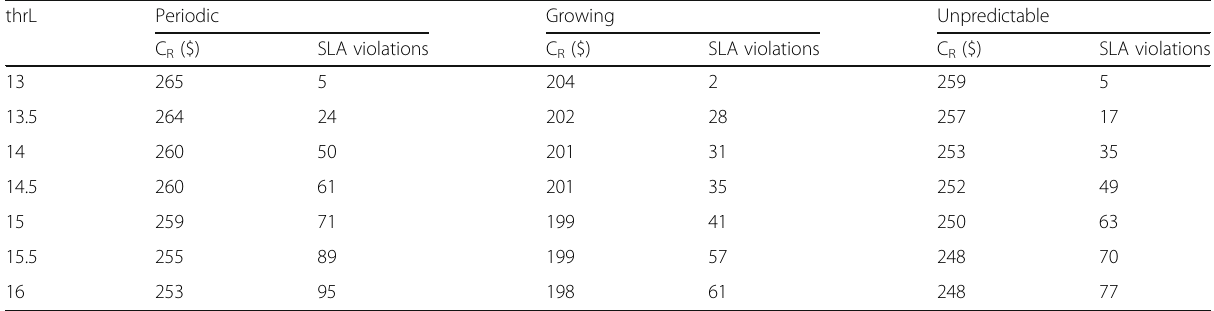
Table 7 Impact of increasing thrL on the cost factors thrL Periodic